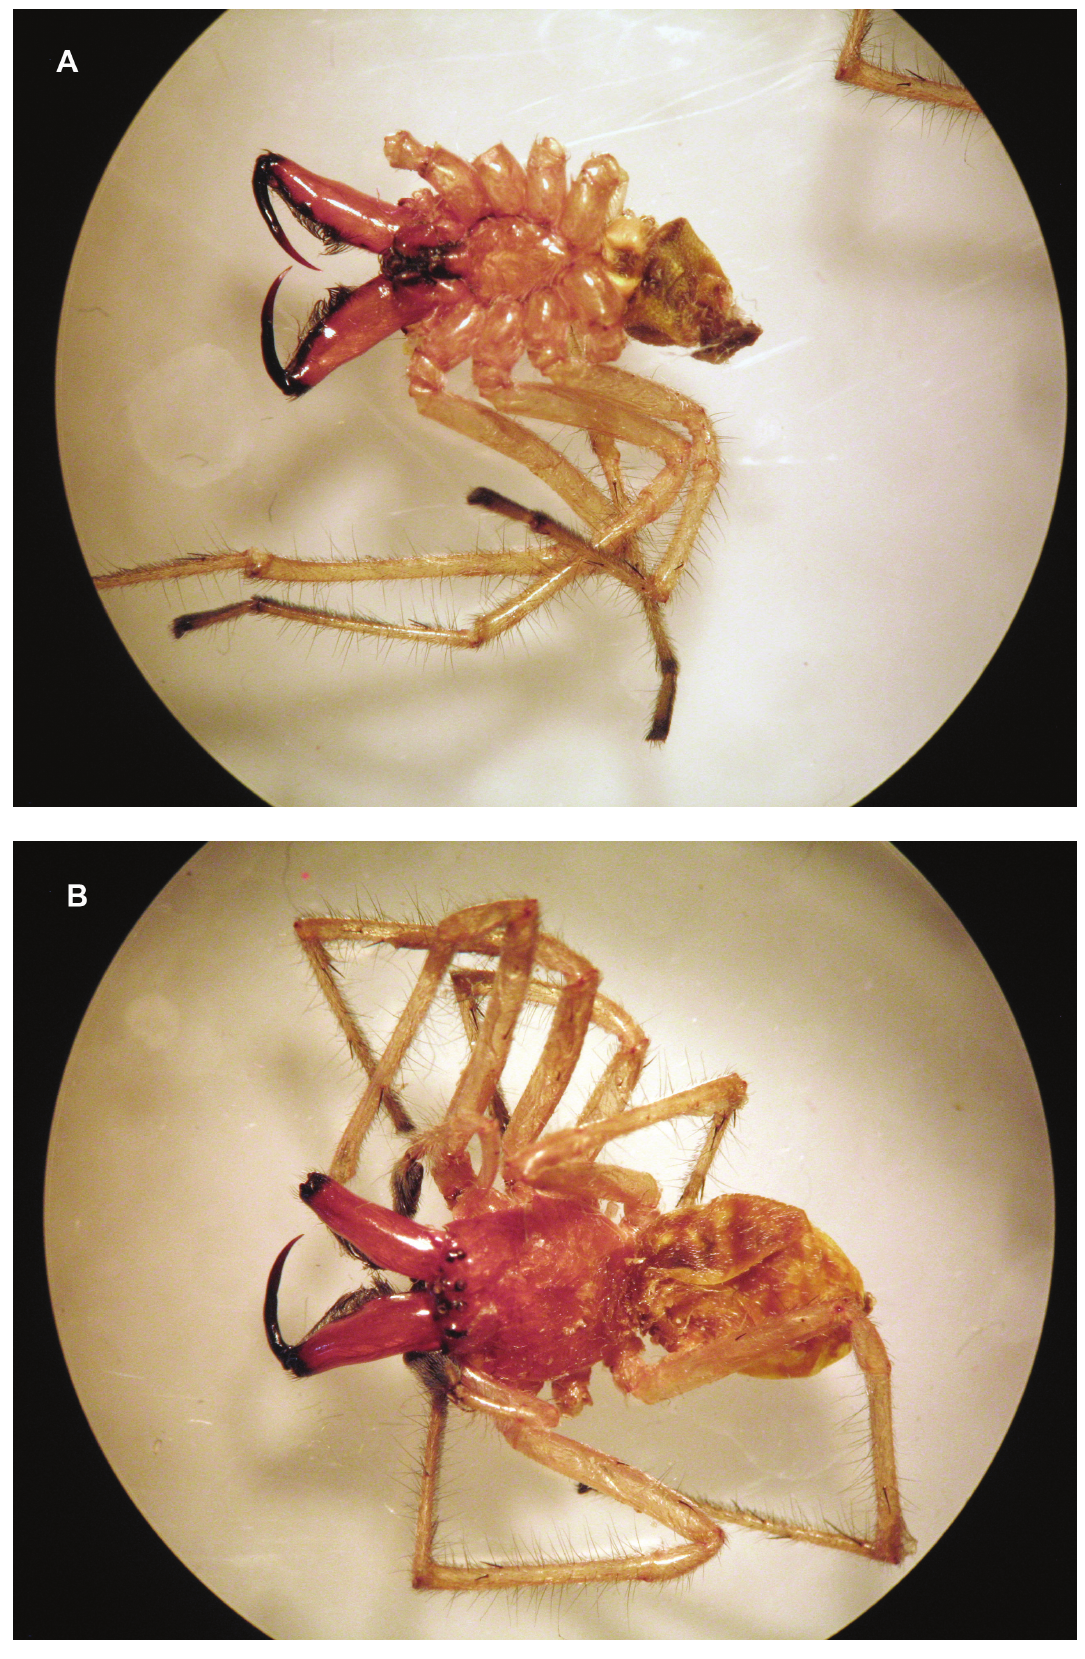
Figure 1. Specimens of Cheiracanthium punctorium collected after the bite and examined under a stereoscope. Though considerably damaged, it is still possible to note the well-developed chelicerae, the yellowish or reddish-orange color of different body parts, and the long hairy legs with dark terminal- segment